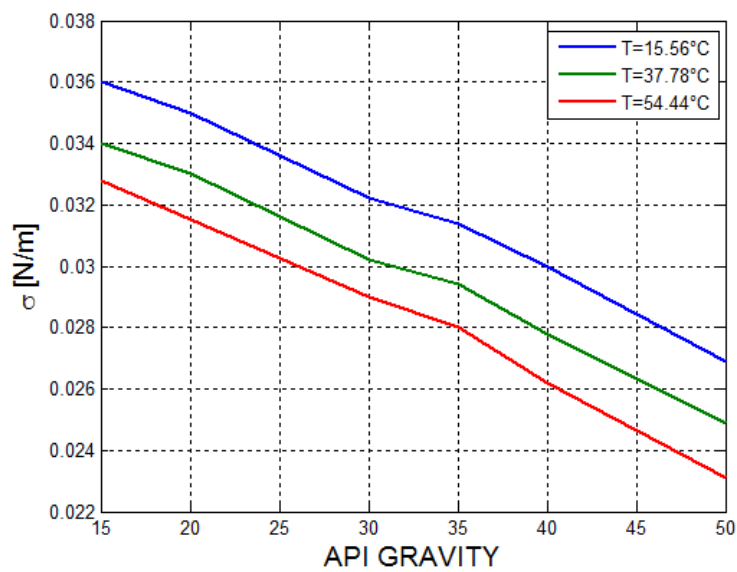
Figure 11. The surface tension of the crude oil as a function of API at three temperatures.